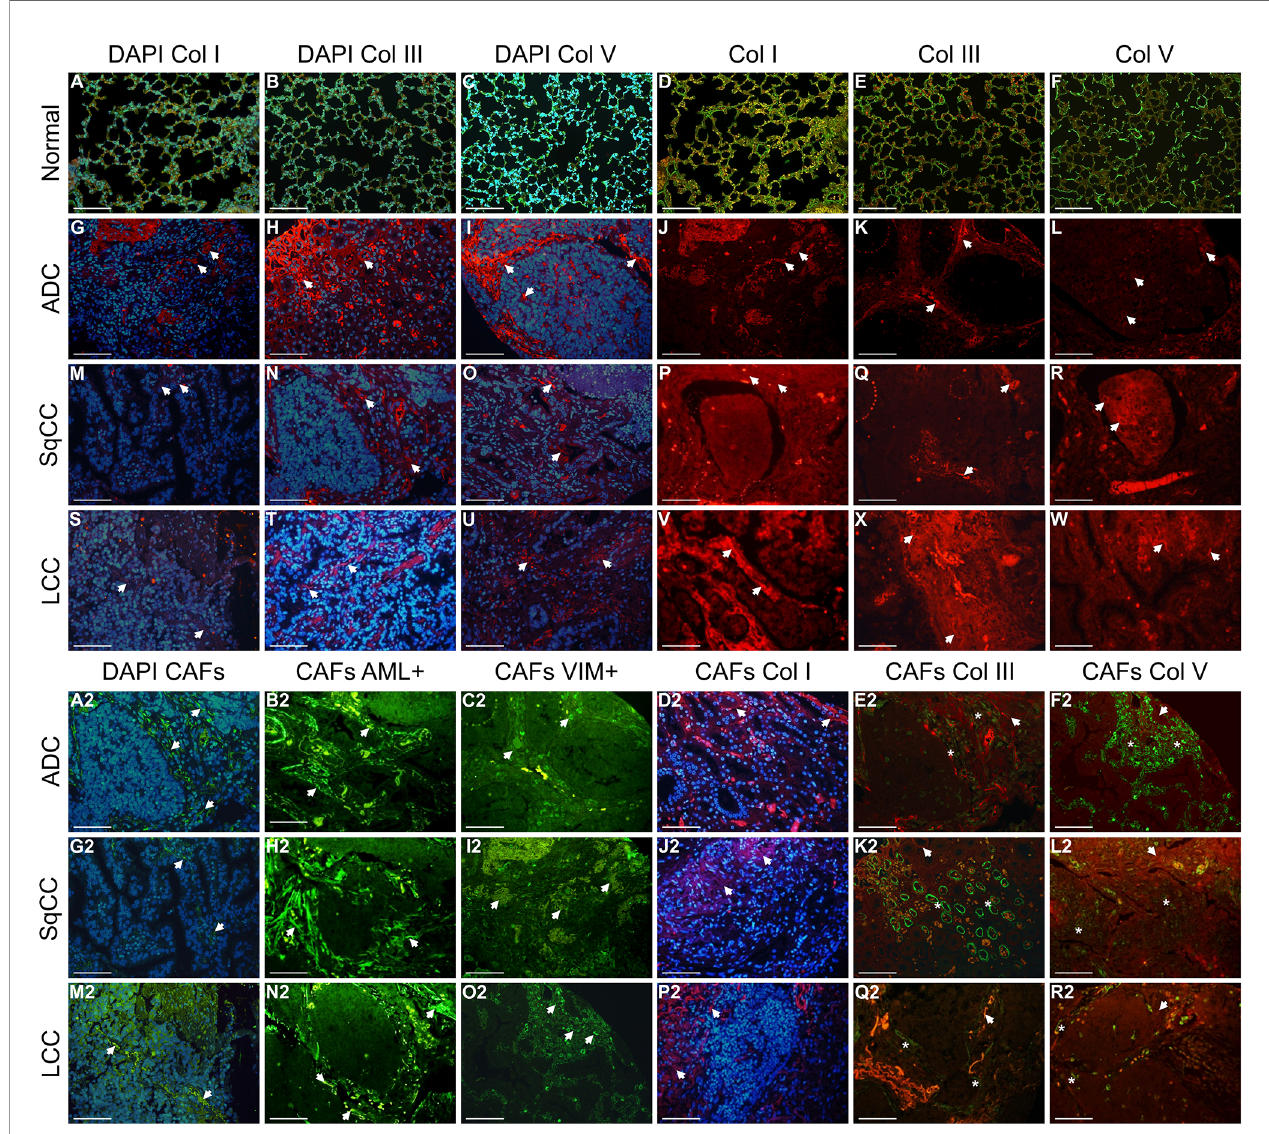
FIGURE 5 | Immuno fl uorescent staining of representative examples of the four matricellular markers in lung ADC, SqCC, and LCC specimens, divided into three compartments: normal tissue (A – F) , tumor tissue, and intermediate tissue (G – W, A2 – R2) . Arrows indicate cell and fi bers expressing each matricellular marker (blue, DAPI; Col fi bers, red; CAFs, green; merge CAFs and Col). (A – F) In normal lung tissue, green birefringence of Col types are visible expressing along of the alveolar septa. (G – W) In tumor tissue, note a similar red birefringence of Col types in the stroma of the three histotypes. (A2 – R2) Intermediate portion of the tumor showing a strong green birefringence of CAFs and red birefringence of Col types. Note the colocalization of CAFs and Col types in the stroma of the intermediate portion of the tumor. Arrows: Col fi bers; asterisks: CAFs. ADC, adenocarcinoma; LCC, large cell carcinoma; SqCC, squamous cell carcinoma; Col I, collagen type I; Col III, collagen type III; Col V, collagen type V; CAFs, cancer-associated fi broblasts. Scale bars: X400, 20